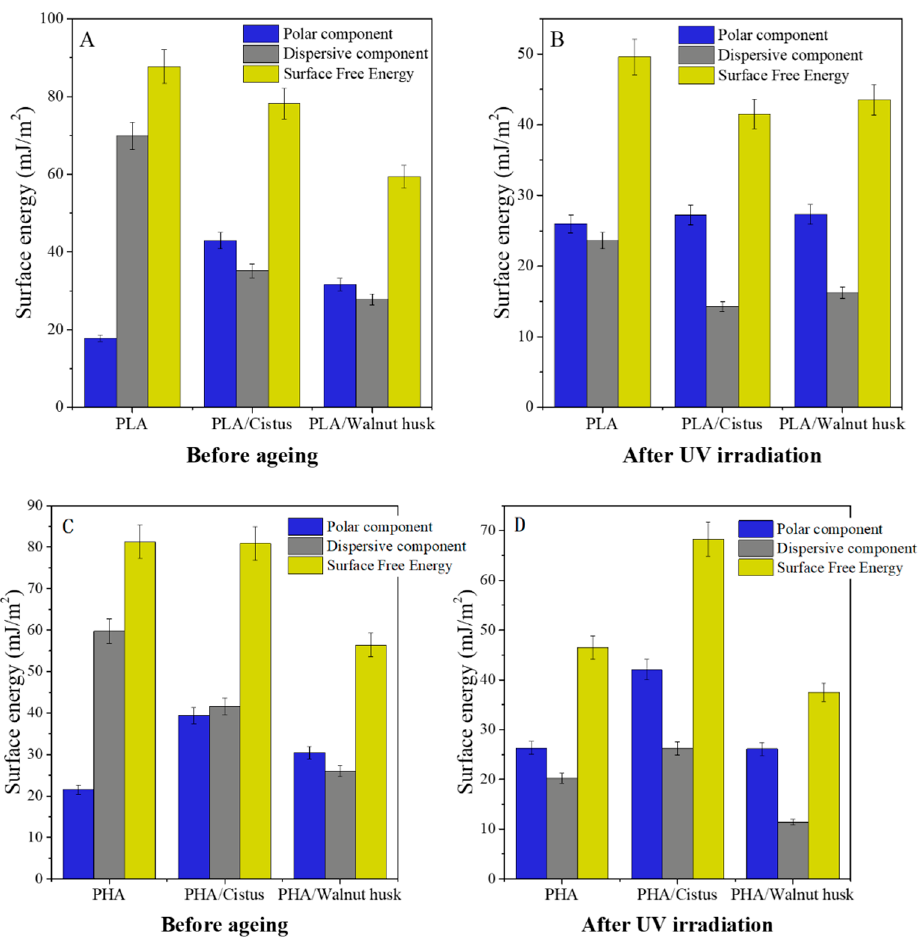
Figure 5. Surface free energy of PLA samples before (A) and after ( B ) UV irradiation. Surface free energy of PHA samples before ( C ) and after ( D ) UV irradiation.